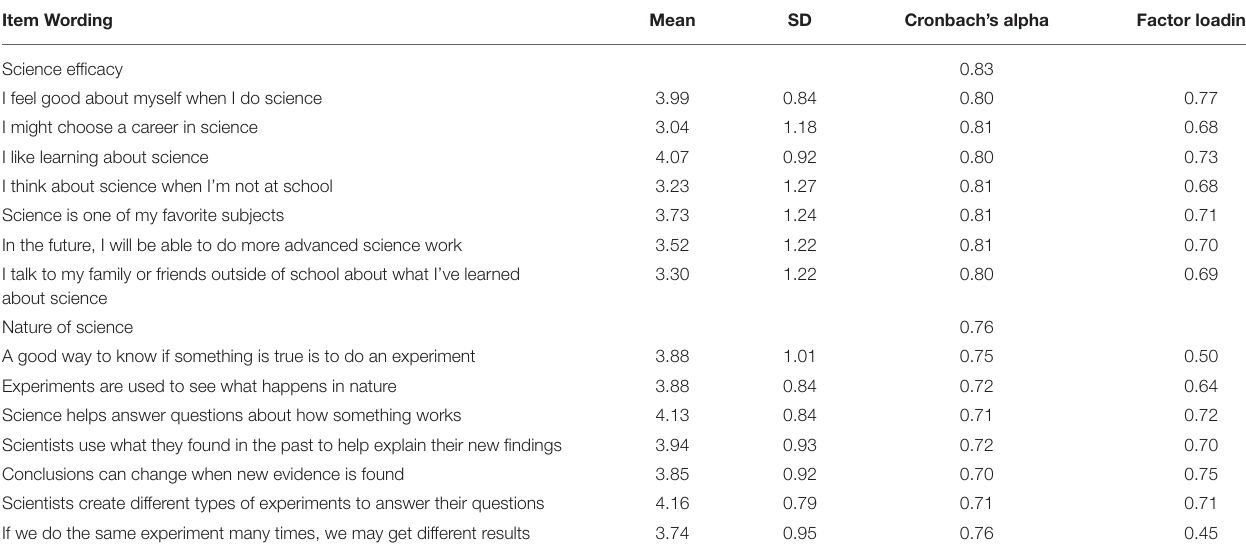
TABLE 2 | Item-level statistics for science efficacy and nature of science scales among students identified as ECBD ( n = 112). Item